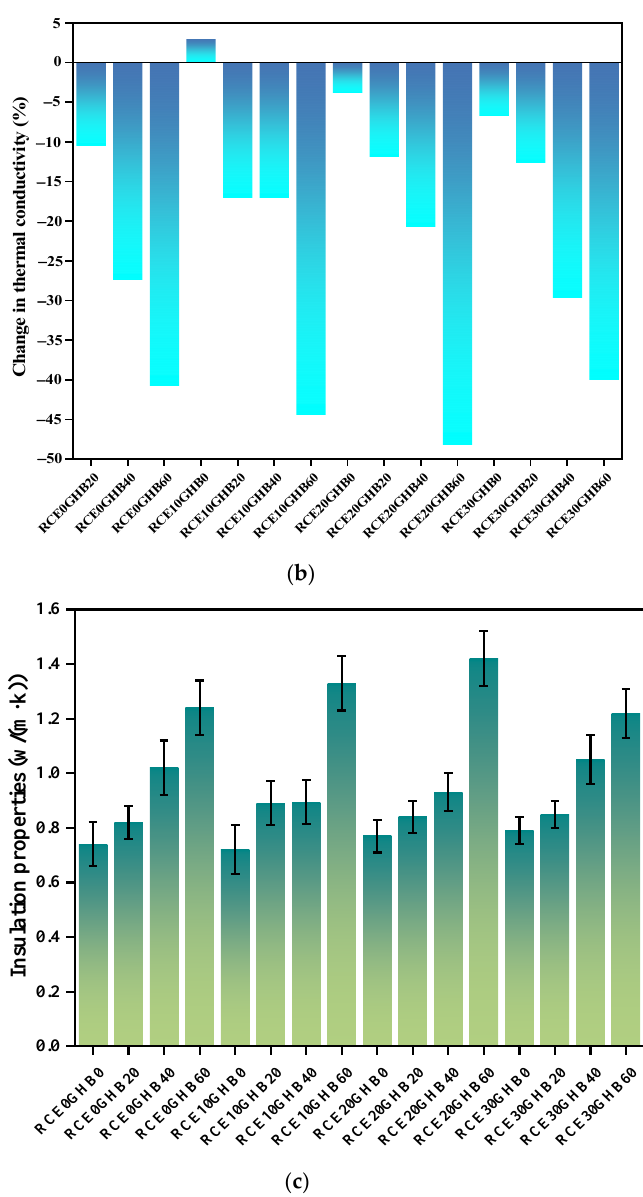
Figure 10. The experimental results and changes of thermal conductivity and insulation property values of RTIC subject to the coupling influence between GHB and RCE. ( a ) The experimental results of thermal conductivity of RTIC; ( b ) the changes of thermal conductivity of RTIC. ( c ) Insulation property values of RTIC.